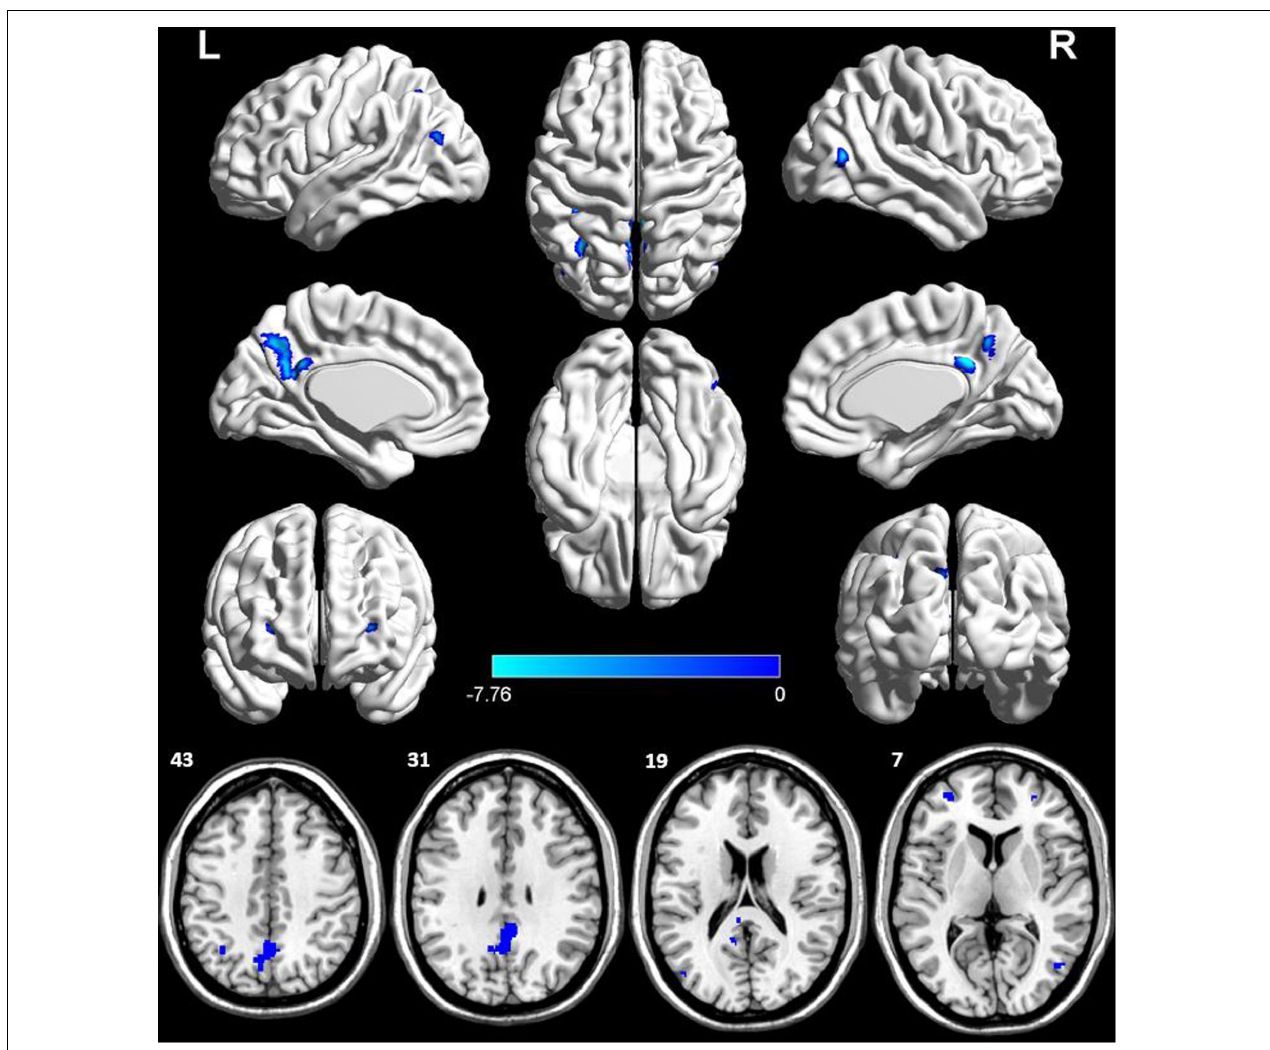
FIGURE 2 | Voxel-wise percentage rCBF changes in patients with AD compared with healthy controls. Decreased rCBF in AD patients compared to healthy controls were mainly located in LPCC, LDLPFC, PDLPFC, LIPL, RMTG, LMOG, and LPCu (with FEW-corrected P < 0.05). L, left; R, right; PPC, posterior cingulate cortex; DLPFC, dorsolateral prefrontal cortex; IPL, inferior parietal lobule; MTG, middle temporal gyrus; MOG, middle occipital gyrus; PCu, precuneus; FEW, Familywise